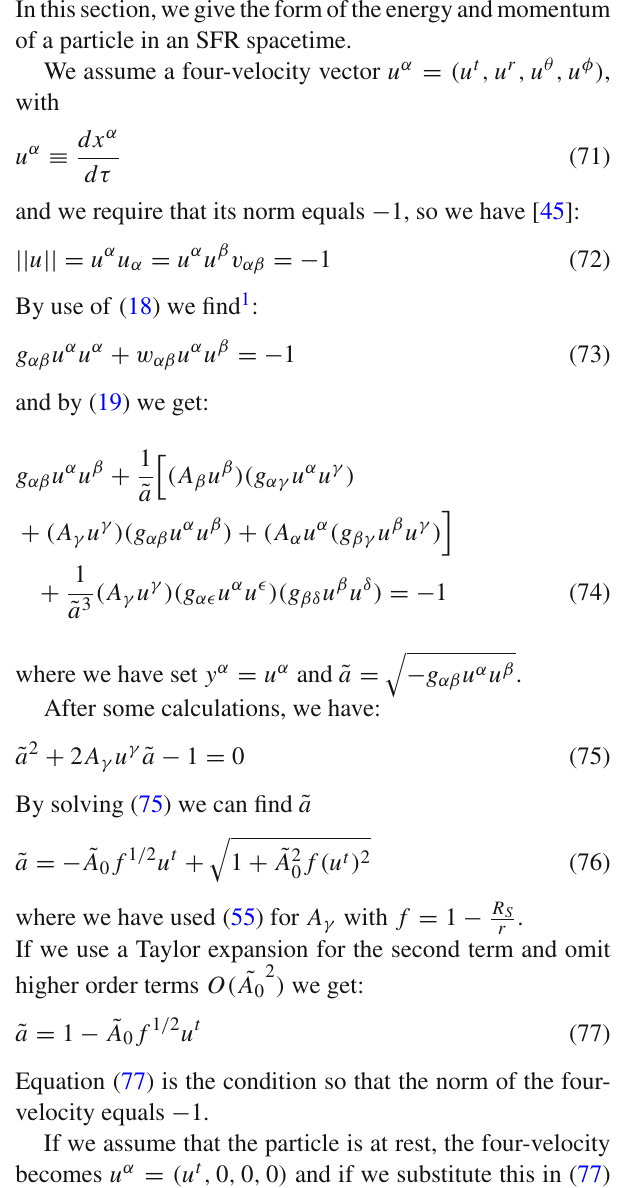
Fig. 6 This is a polar graph of the timelike paths in the SFR model in comparison to the geodesics in GR for E = 1 . 2, L = 4, r 0 = 5 and ( a , b , c ) = ( 1 , 10 , 10 )